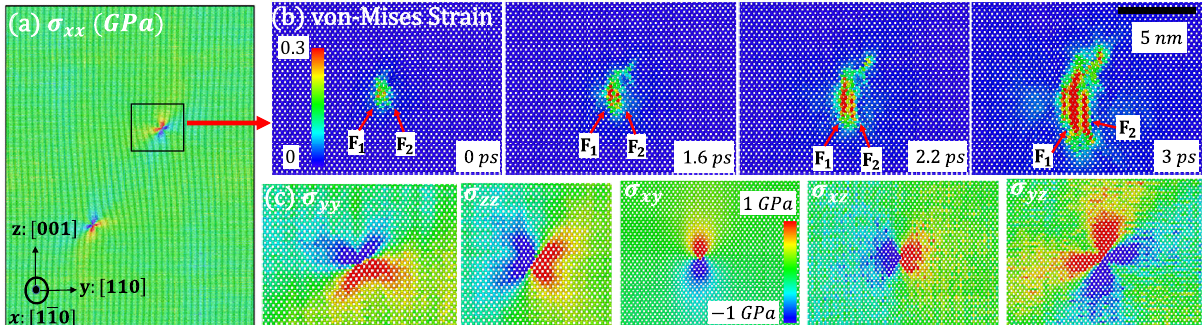
Fig. 1 Field of internal stresses due to dislocations and nucleation of twinned Si-II at two dislocations. a Computational model of a single Si crystal with shuf fl e 60° dislocation dipole inserted by employing dislocation displacement 27 at constant hydrostatic pressure, including internal stress distribution due to dislocations. Stress fi elds of dislocations practically do not overlap. b Evolution of von-Mises strain distribution. c Distribution of all internal stresses due to dislocation from MD simulation. The twined Si-II nucleates from single dislocation from the beginning and grows along the ½ 110 (cid:3) (i.e., y ) direction. The ð 110 Þ twinning plane is consistent with the prediction from crystallographic theory 1 and the current